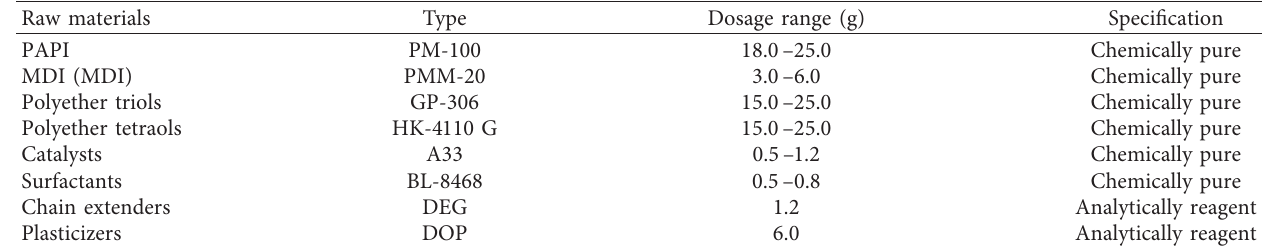
Table 2: Type of raw